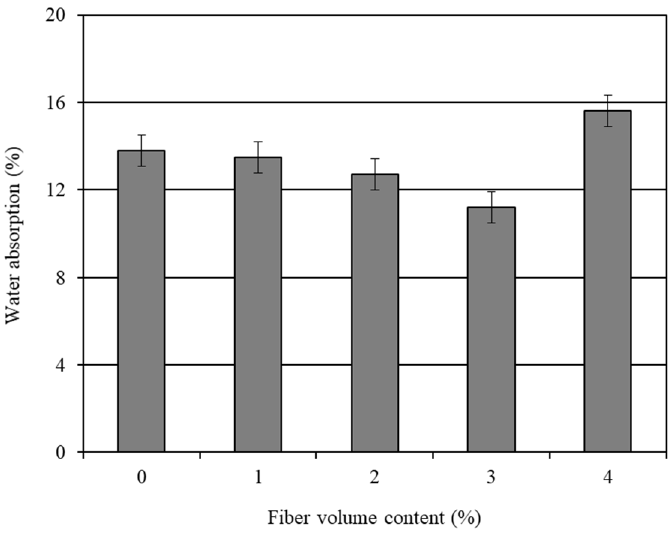
Figure 4. Influence of carbon fibers on the 28-day water absorption of mortar composite.